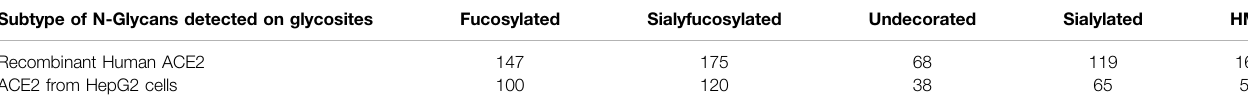
The number of glycofmorms was shown in Table 1 .